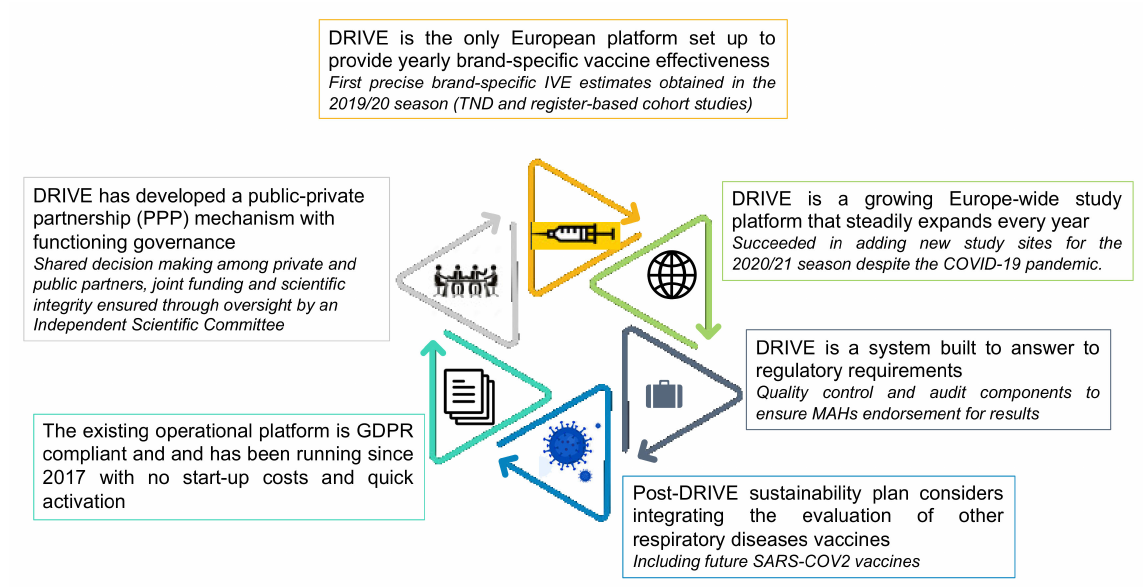
Figure 4. DRIVE key assets and achievements. Since its inception in 2017, DRIVE has achieved several milestones and developed key assets that make it a unique study platform for brand-specific VE studies in Europe. DRIVE has developed methods to pool brand-specific IVE